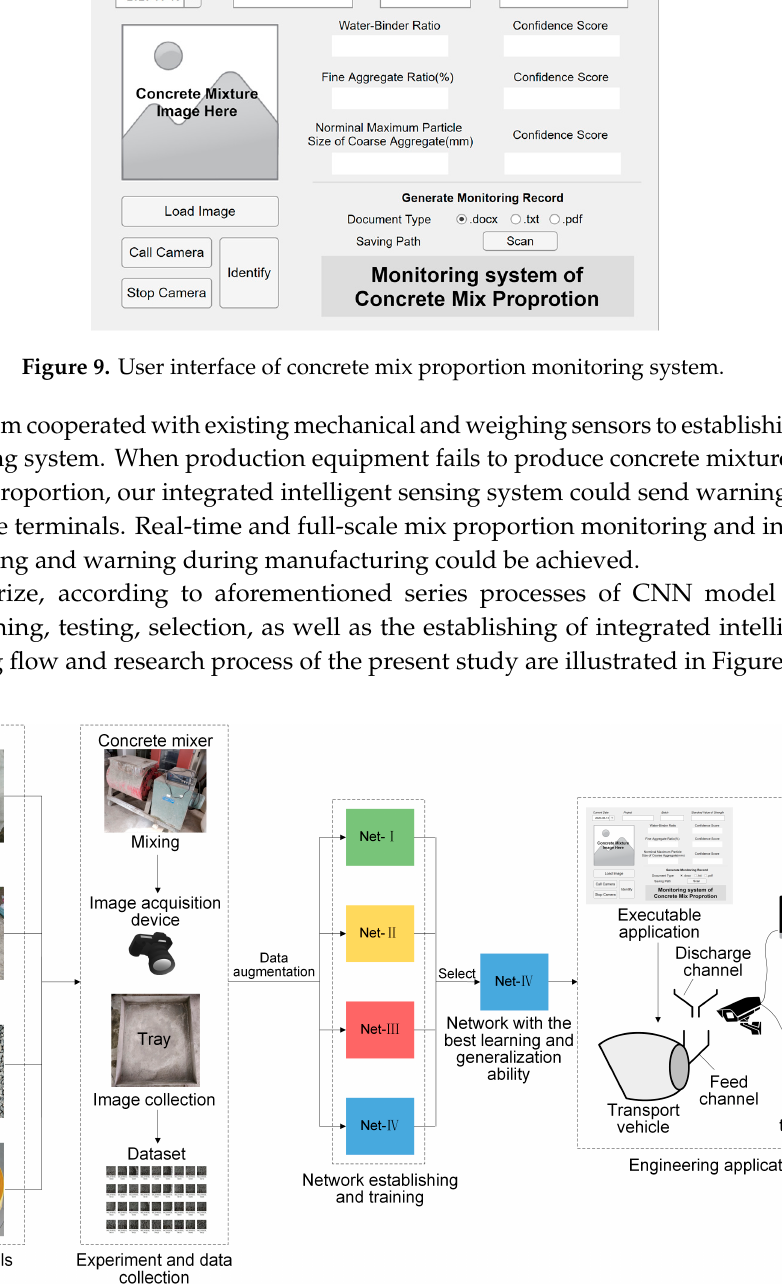
Figure 10. Working flow and research process of the present study.